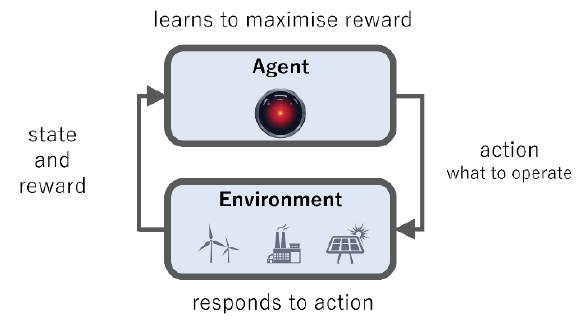
Fig. 4. Agent-environment interaction in